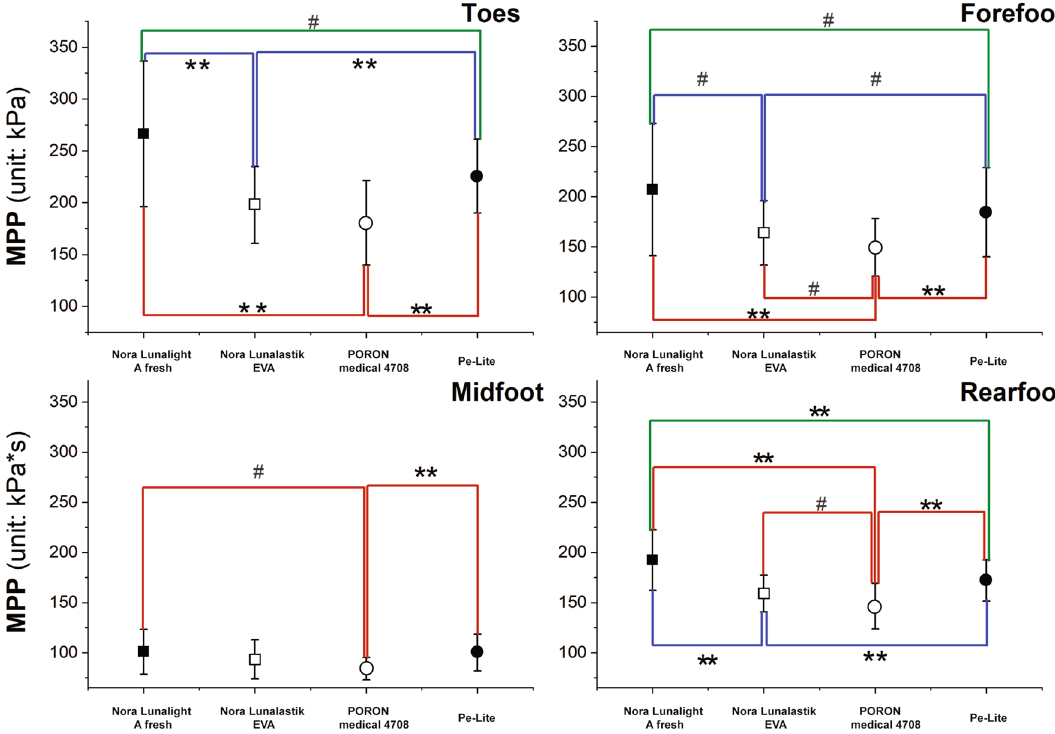
Figure 4. MPP in four different plantar regions with use of four insoles. Notes: # P < 0.05 and ** P < 0.001.